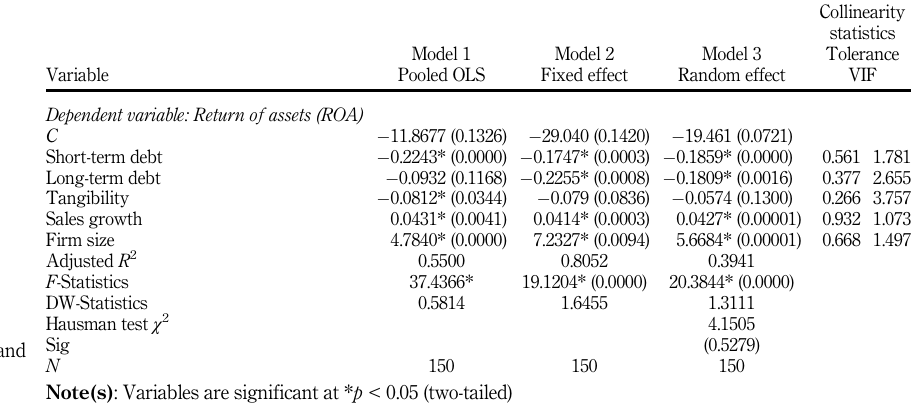
Table 4. Pooled OLS, fixed and random effects regression